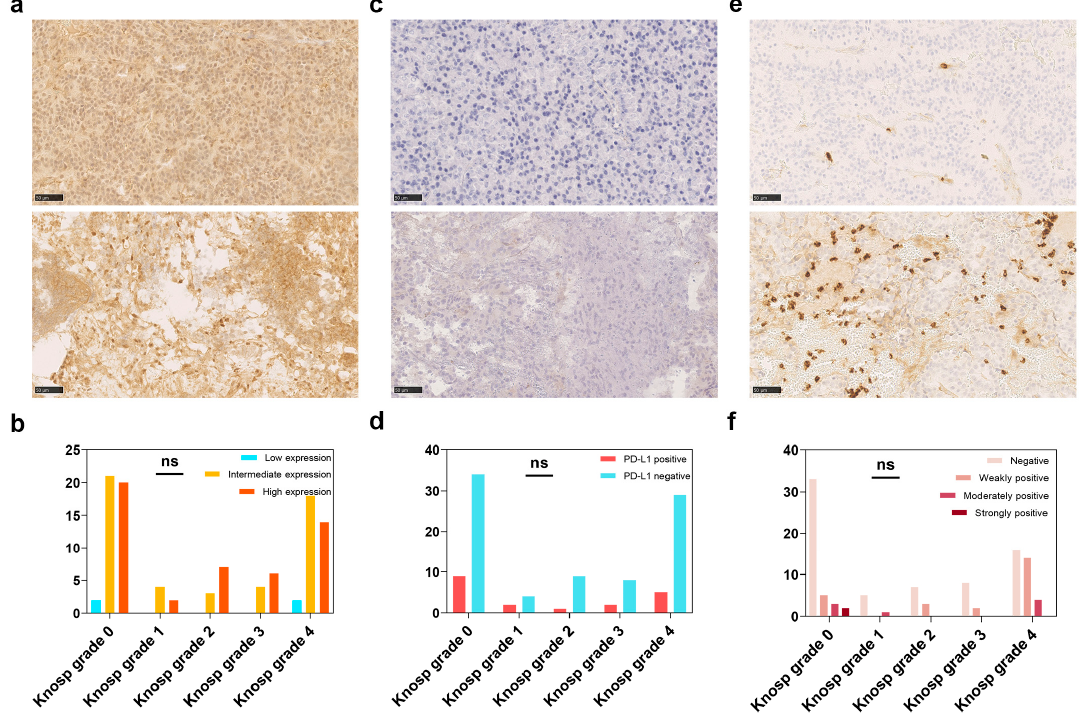
Figure 2. Correlation heatmap (Spearman correlation) of immune cells and pro-invasive factors. Only statistically significant differences are displayed.